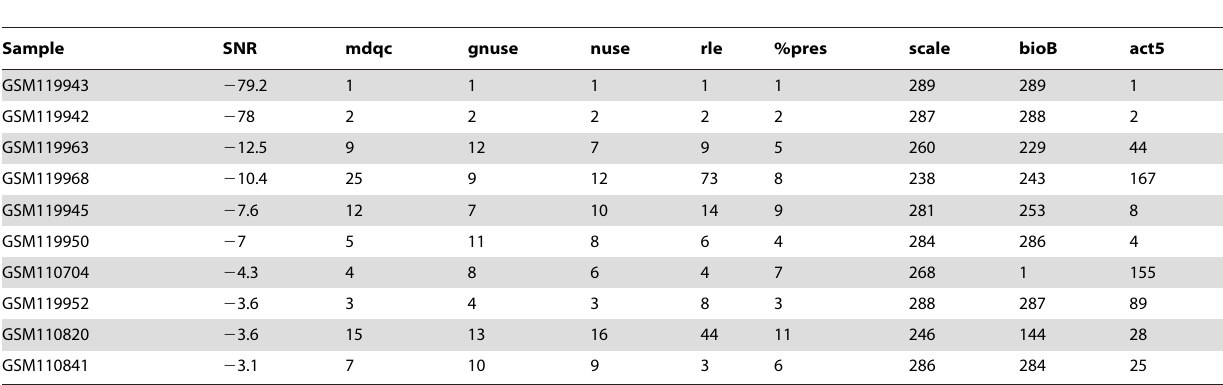
Table 2. Comparison of SNAGEE, MDQC, GNUSE and sample quality metrics on a breast cancer study (GSE4922).